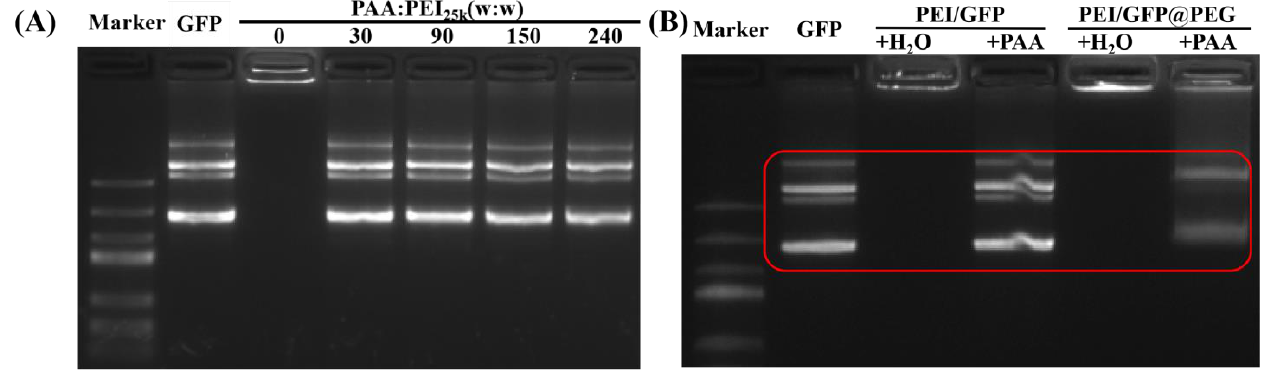
Figure 3. ( A ) Combination of PAA with PEI in different mass ratios to release GFP. ( B ) PAA combined with PEI to release GFP in PEG gel system.